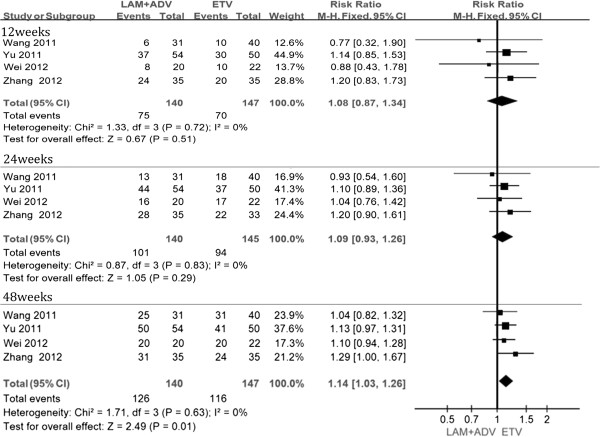
Effect of LAM + ADV vs. ETV on virologic response.